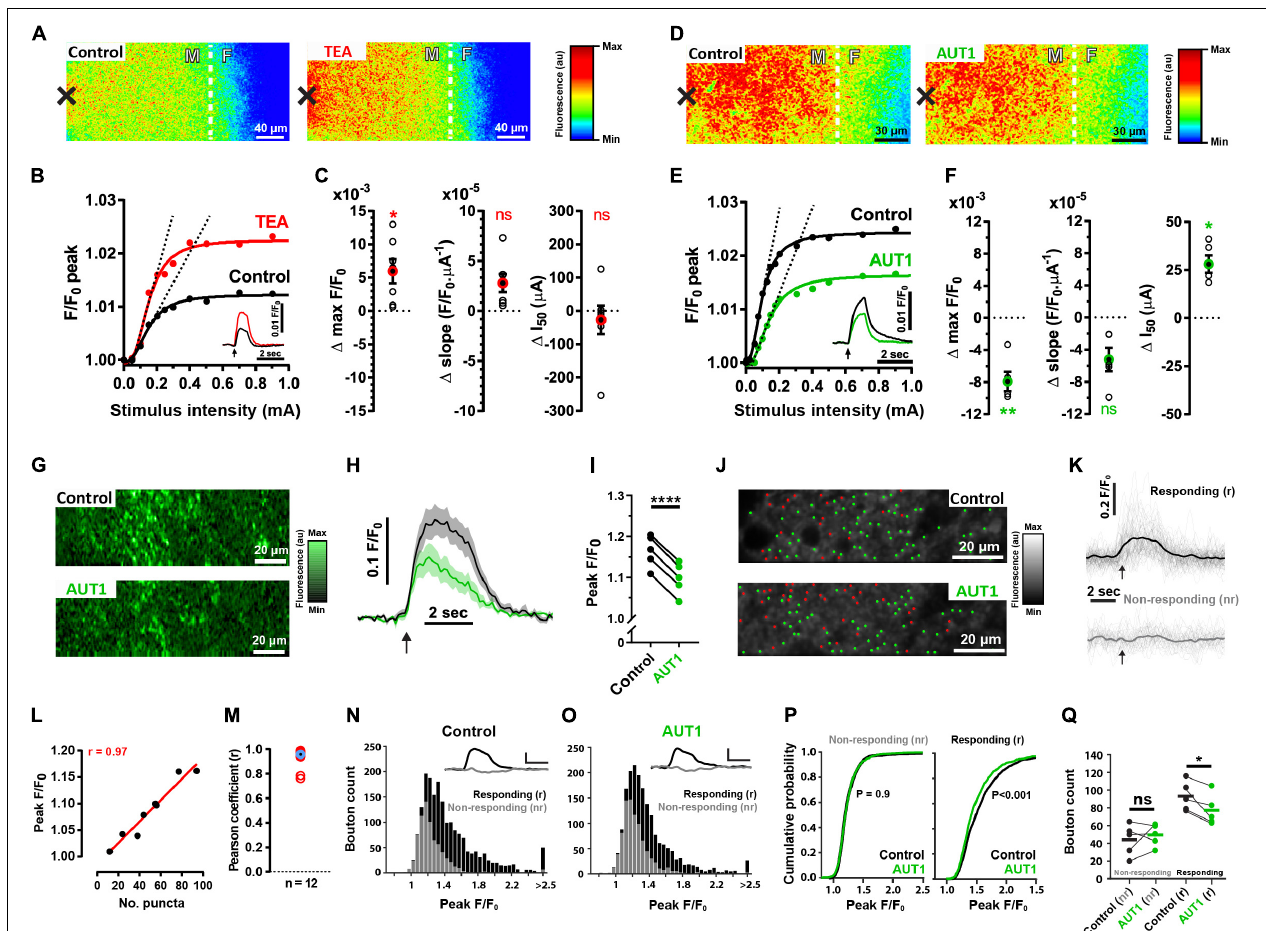
FIGURE 4 | Effects of positive Kv3 K + current modulation on the SyGCaMP2 fluorescence response following parallel fiber stimulation. (A,D) Heat maps depicting an increase in SyGCaMP2 fluorescence in response to parallel fiber stimulation (500 µ A, 50 Hz, 100 pulses) in the control condition ( A,D , left) and following perfusion of TEA ( A , right) or AUT1 ( D , right). The black crosses depict the position of the stimulation electrode. The white dashed lines show the border between the molecular (white “M”) and fusiform (white “F”) layer. (B,E) SyGCaMP2 fluorescence maximal peak response as a function of stimulation intensity (mA) for the recording shown in panels (A,D) , respectively. Peak responses are fitted using a four parameter Hill function. Dashed lines are linear regressions fitted to the linear, rising phase of the transfer function. Insets: SyGCaMP2 fluorescence in response to a 500 µ A pulse train (50 Hz, 2 s) current intensity stimulation (time of delivery illustrated by black arrows), in the control condition (black traces) and following perfusion of TEA ( B , red trace) or AUT ( E , green trace). (C,F) Change in maximal F/F 0 (obtained from the Hill function, left), the rising slope (obtained from the linear regression fits to the rising phase of the Hill function, middle) and the half activation point (obtained from the Hill function, right) following perfusion of TEA (C) or AUT1 (F) . Empty black circles represent results from a single brain slice and filled black circles with red (C) or green (F) outlines represent the mean ( C , n = 7; F , n = 5). (G) Multiphoton microscopy images showing changes in calcium fluorescence within an area bordering the molecular and fusiform layers, following parallel fiber stimulation (750 µ A, 50 Hz, 100 pulses) in the control (top) and AUT1 (bottom) conditions. (H) Average SyGCaMP2 fluorescence as a function of time, evoked in response to a 50 Hz (100 pulses) parallel fiber stimulation (time of delivery indicated of black arrow), in the control (black) and AUT1 (green) conditions ( n = 5). (I) Perfusion of AUT1 decreased the peak fluorescence. (J) Multiphoton microscopy images (top: control; bottom: AUT1) showing a field between the molecular and fusiform layer, with green and red dots representing the location of responding and non-responding boutons, respectively. (K) Single bouton fluorescence as a function of time for the responding (top) and non-responding (bottom) boutons depicted in panel (J) (top). The thick lines represent the average responses. The black arrows denote the time at the start of the stimulation. (L) Peak fluorescence from the entire imaging window plotted against the number of responding boutons for a single brain slice. Individual points were obtained from current intensities ranging from 100 to 700 µ A. The correlation coefficient between these two variables was 0.97. (M) Similarly obtained Pearson correlation coefficients (red circles) for 12 brain slices. The blue circle with the black center shows the average correlation coefficient ( r = 0.96). (N,O) Histograms showing the distribution of peak values (peak F/F 0 ) for responding (black) and non-responding (gray) boutons in the control (N) and AUT1 (O) conditions. Insets show the mean bouton fluorescence trace for the non-responding (gray) and responding (black) boutons. Horizontal and vertical scale bars are 2 s and 0.2 F/F0 respectively. (P) Cumulative probability plots showing the distribution of peak values (peak F/F0) for non-responding (left) and responding (right) boutons in the control (black) and AUT1 (green) conditions. The printed p values show results from Kolmogorov-Smirnov tests between the control and AUT1 conditions. (Q) Perfusion of AUT1 failed to affect the number of non-responding boutons (left) but did cause a significant decrease in the number of responding boutons (right) (C,F) Error bars = SEM. (H) Shaded error bars = SEM. * p < 0.05, ** p < 0.01, **** p <